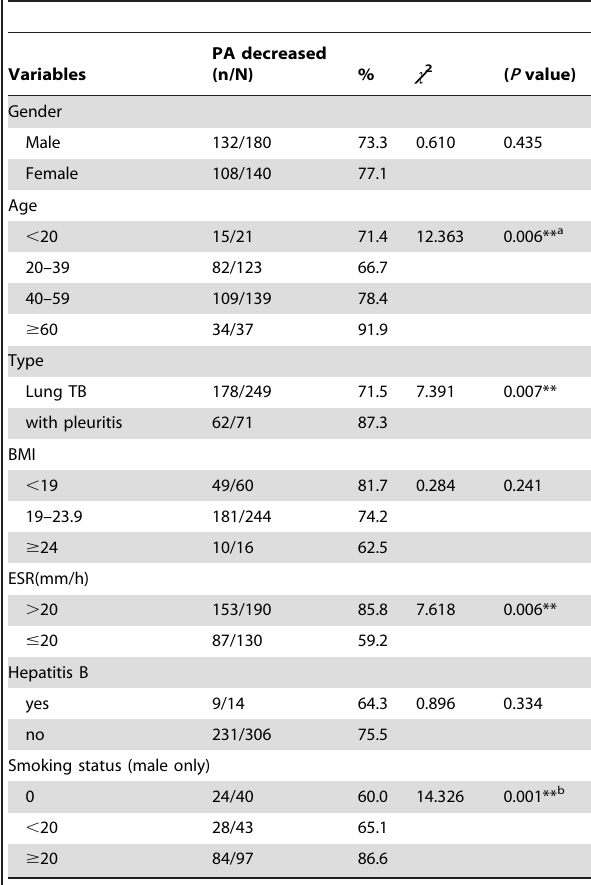
Table 2. Influencing factors of PA decrease in patients with